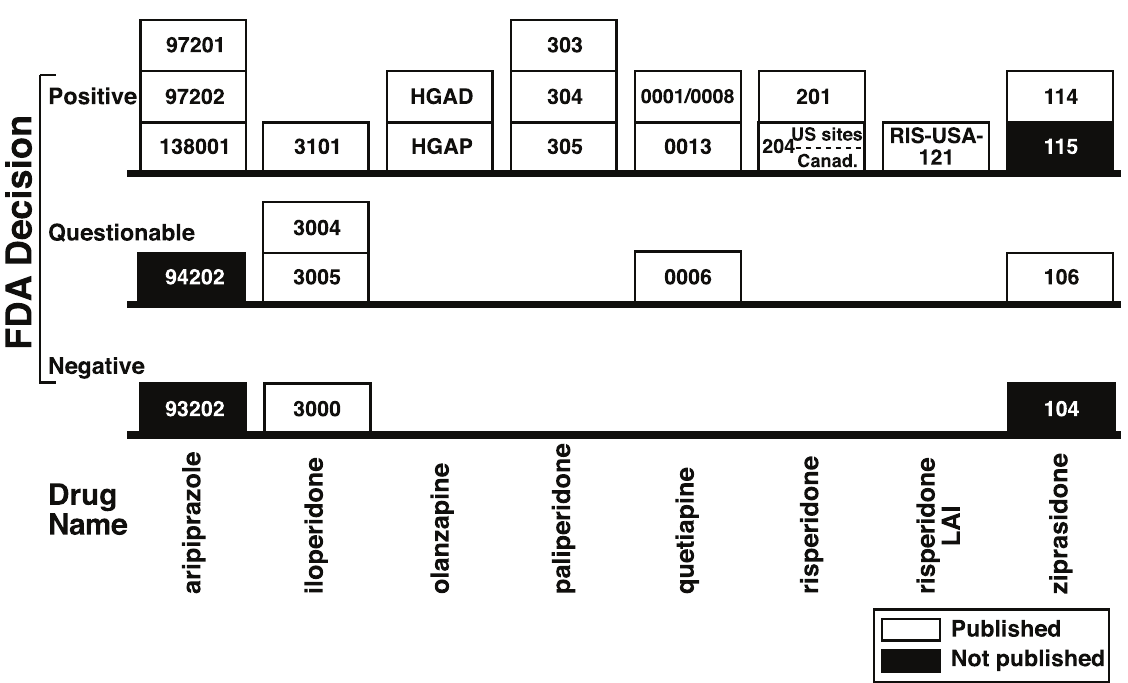
Figure 1. Trial outcome according to the FDA versus publication status of 24 premarketing trials of eight second-generation antipsychotics. Published trials are shown as white boxes, unpublished trials are shown as black boxes, and the trial numbers are shown within the boxes. Unpublished trials were, with one exception, not positive (either negative or questionable). Please see the text for narrative descriptions of several of these trials. Please note that the number of white boxes does not equal the number of journal articles (see text and Table 2): iloperidone trials 3000, 3004, and 3005 were published in a single journal article, and risperidone trial 204 was published as two separate journal articles, as though the US and Canadian sites constituted two distinct positive